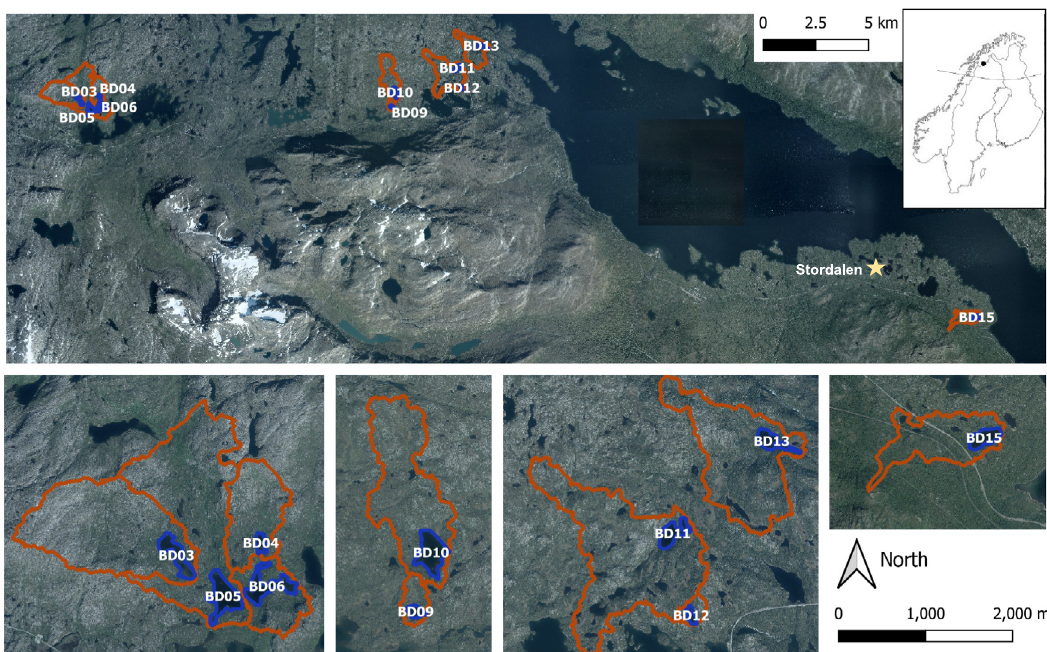
Fig. 1 Map of the sampled lakes in Northern Sweden. Blue color indicates the study lakes and red lines show the corresponding catchments. The yellow star indicates the location of the Stordalen mire (Image source: © Lantmäteriet, 2021).